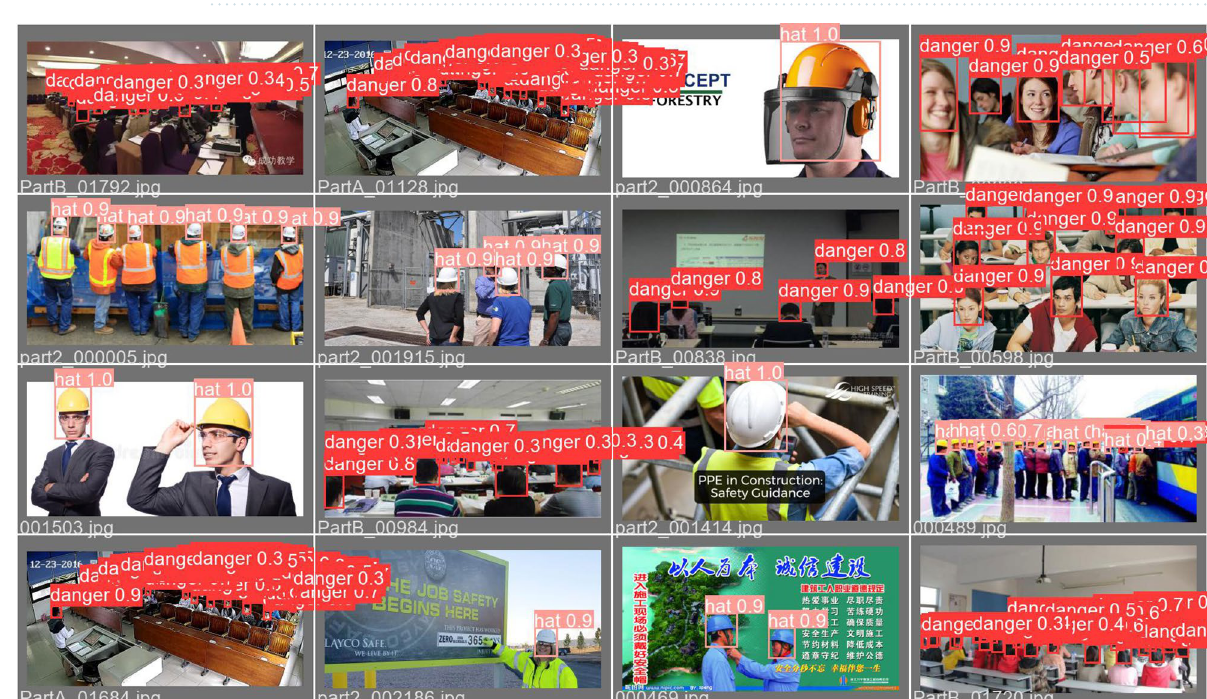
Figure 12. The detection results of